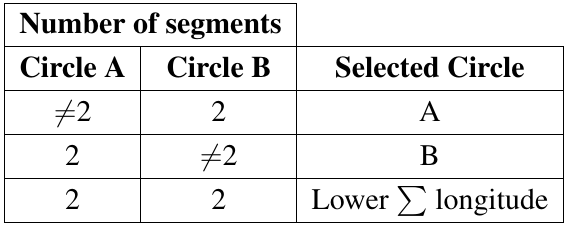
Table 1. Palm circle selection look-up table.